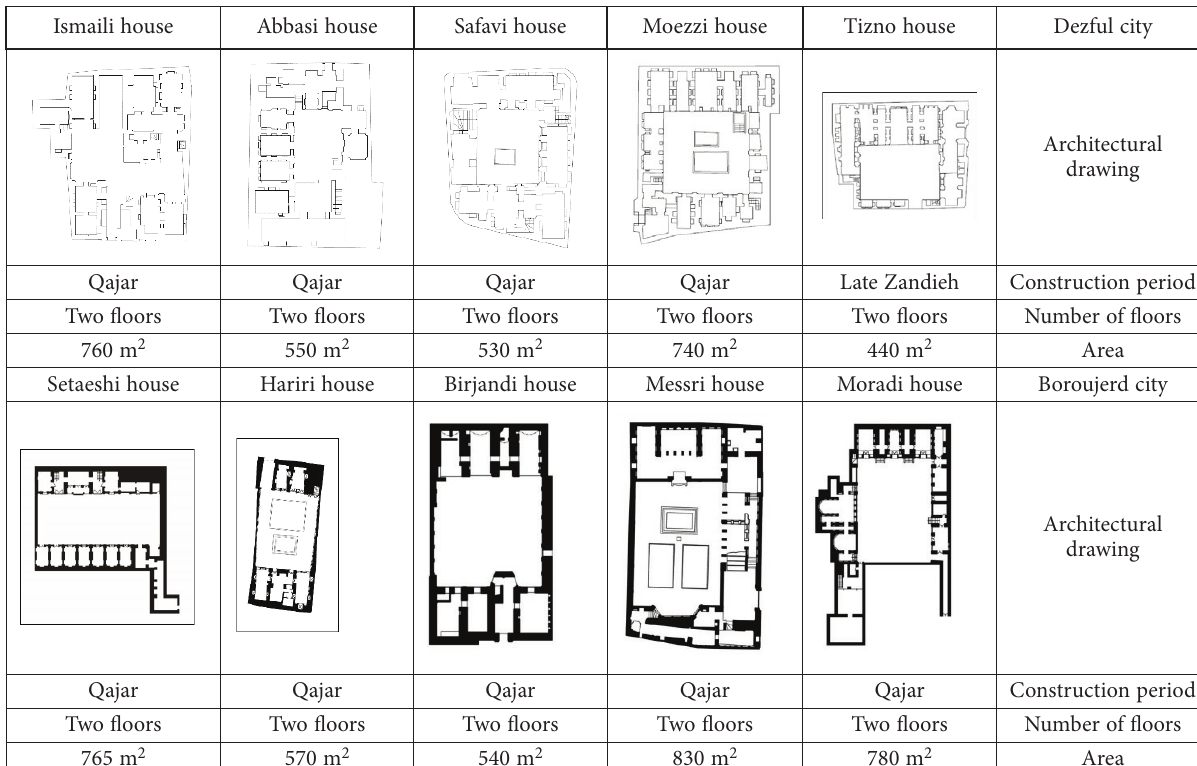
Table 4. Selected research houses (source: compiled by the